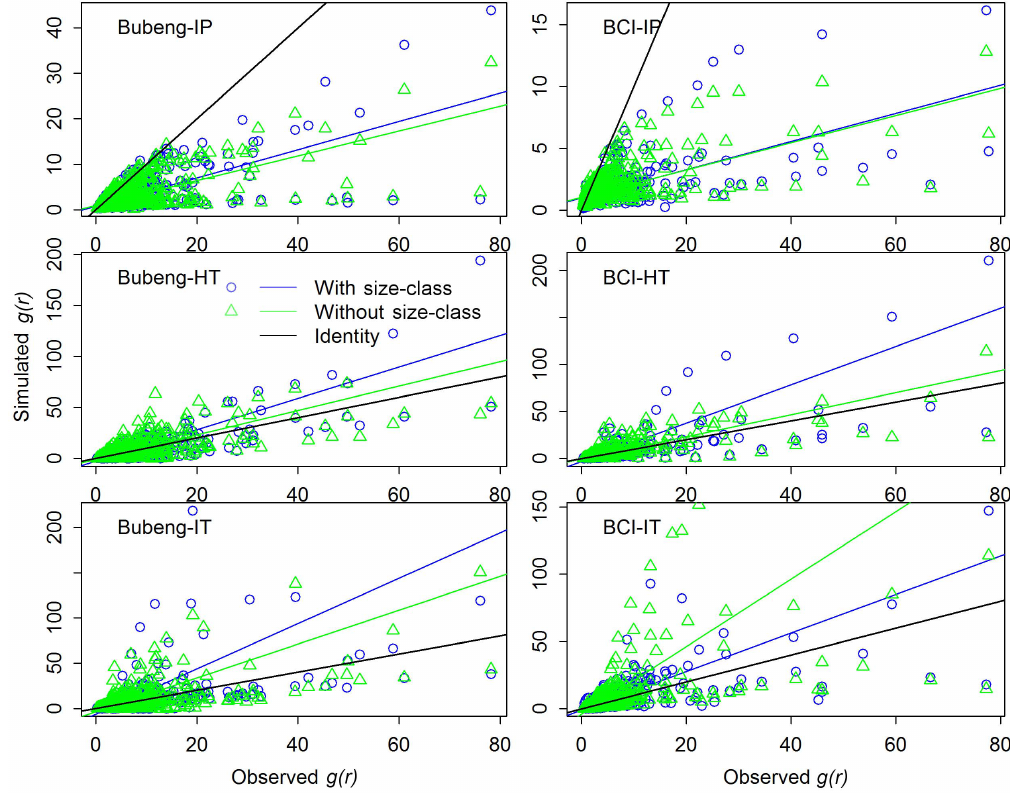
Figure 6. Comparison of observed g(r) of species at DBH Class 0 (that is: size-classes 1, 2 and 3 combined) with g(r) simulated by three point process models with and without size-class effect. Abbreviations as for Figure 4.